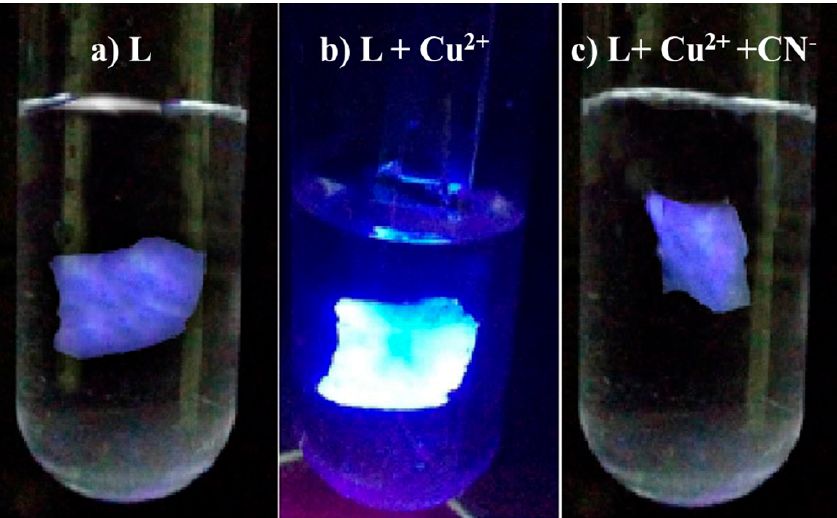
Figure 11. ( a ) PS + 2% L-membrane under UV light in water; ( b ) PS + L- membrane in aqueous solution containing 1 × 10 − 4 M of Cu 2+ under UV light; ( c ) PS + L- Cu 2+ in CN − containing aqueous solution with a concentration of 1 × 10 − 4 M.